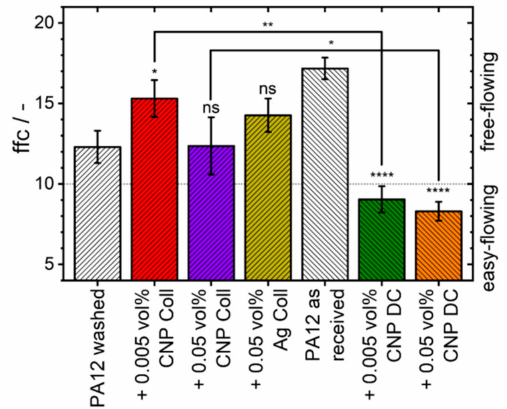
Figure 1. Flowability characteristics of PA12 powder and its composites measured by a ring shear cell at a pre-consolidation stress of 1 kPa. Due to the additional washing step before the colloidal additivation, colloidal composite powders are compared to washed PA12 powder while dry-coated composites are compared to PA12 powder as received. An increase in significance is depicted with an increase in the number of asterisks, while no significant differences are declared as “ns” ( p > 0.05). Results are based on three